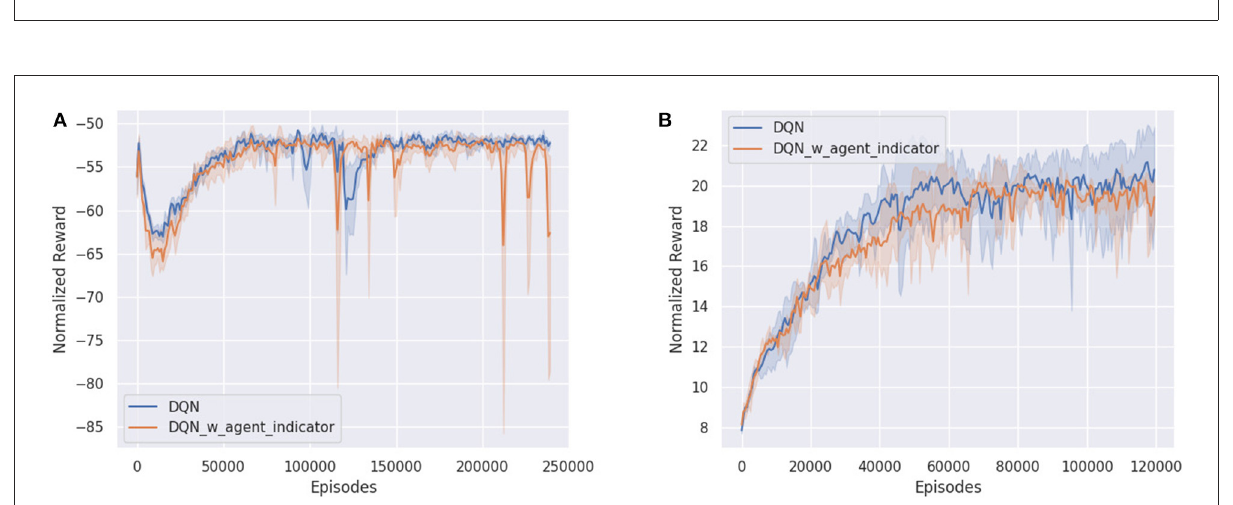
FIGURE7 Training curves of various algorithms in the Simple Adversary environment. (A) Shows the reward of the adversary, (B) shows the reward of a cooperative agent (both cooperative agents obtain the same reward).